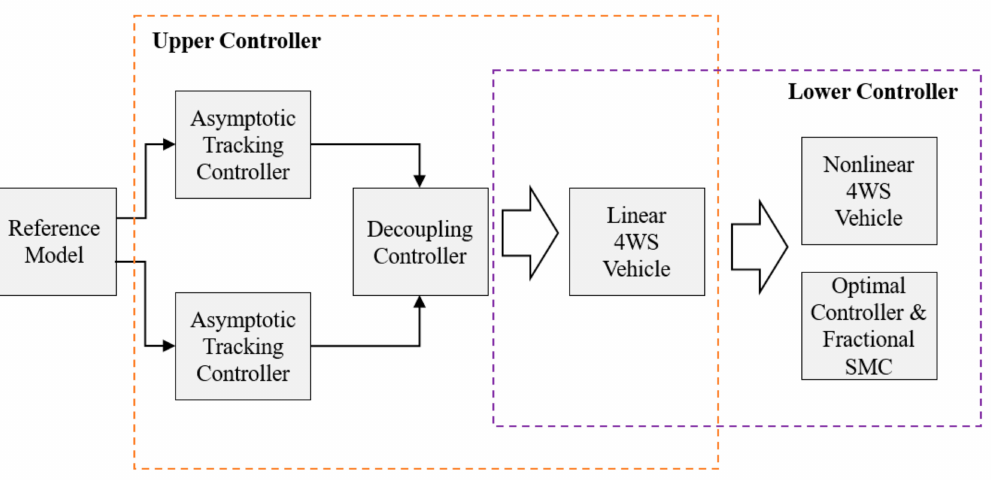
Figure 10. Control diagram of the 4WS control system in